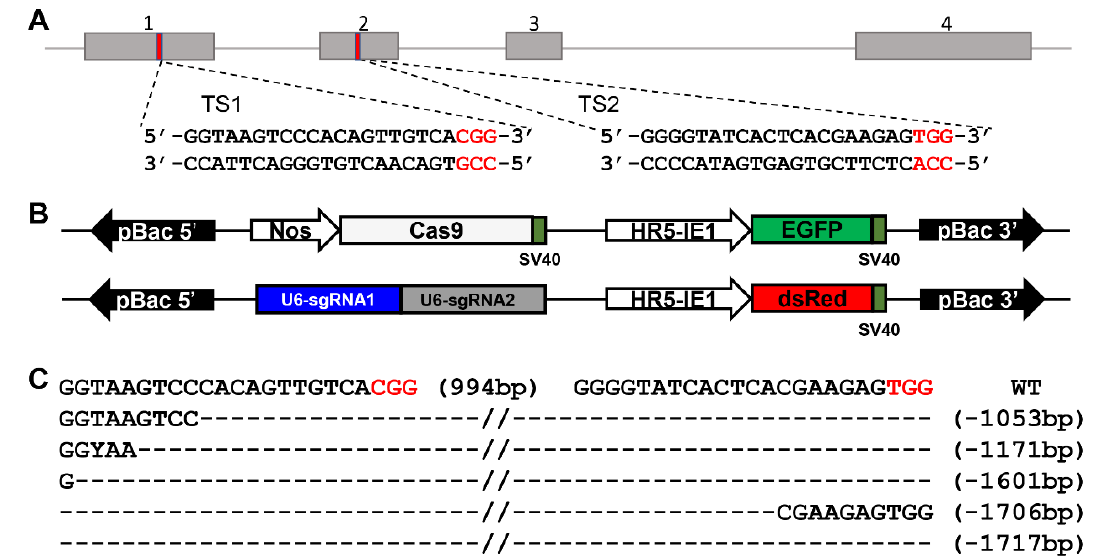
Figure 3. BmSfp62 knockout using CRISPR/Cas9. ( A ) Genomic structure of BmSfp62 . ( B ) Schematic representations the Nos-Cas9 and U6-sgRNA . ( C ) Base deletion. Black is target sequences; red is PAM sequences. The deletion size is indicated to the right of the sequence.